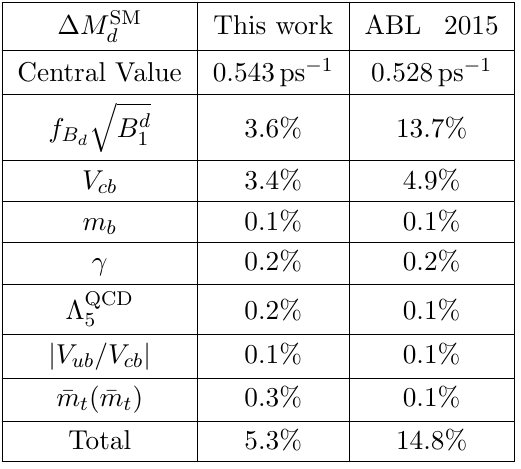
Table 13 . List of the individual contributions to the theoretical error of the mixing quantity (cid:1) M d and comparison with the values obtained in 2015